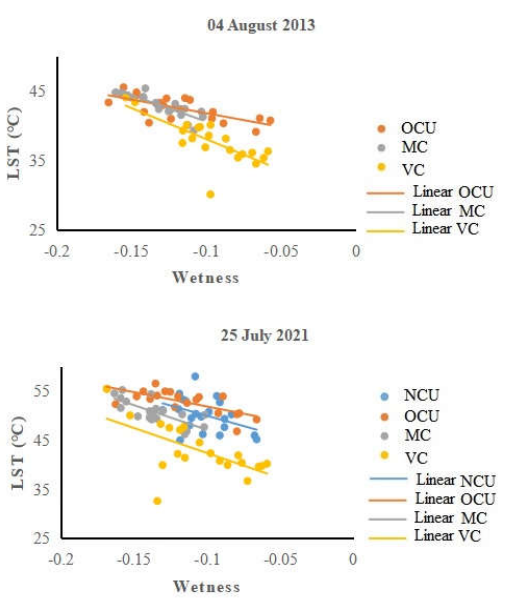
Figure 4. LST vs TCT based Wetness for different residential community types as recorded by two specific observations of the Landsat-8 OLI/TIRS, acquired on 04 August 2013 and 25 July 2021 respectively.